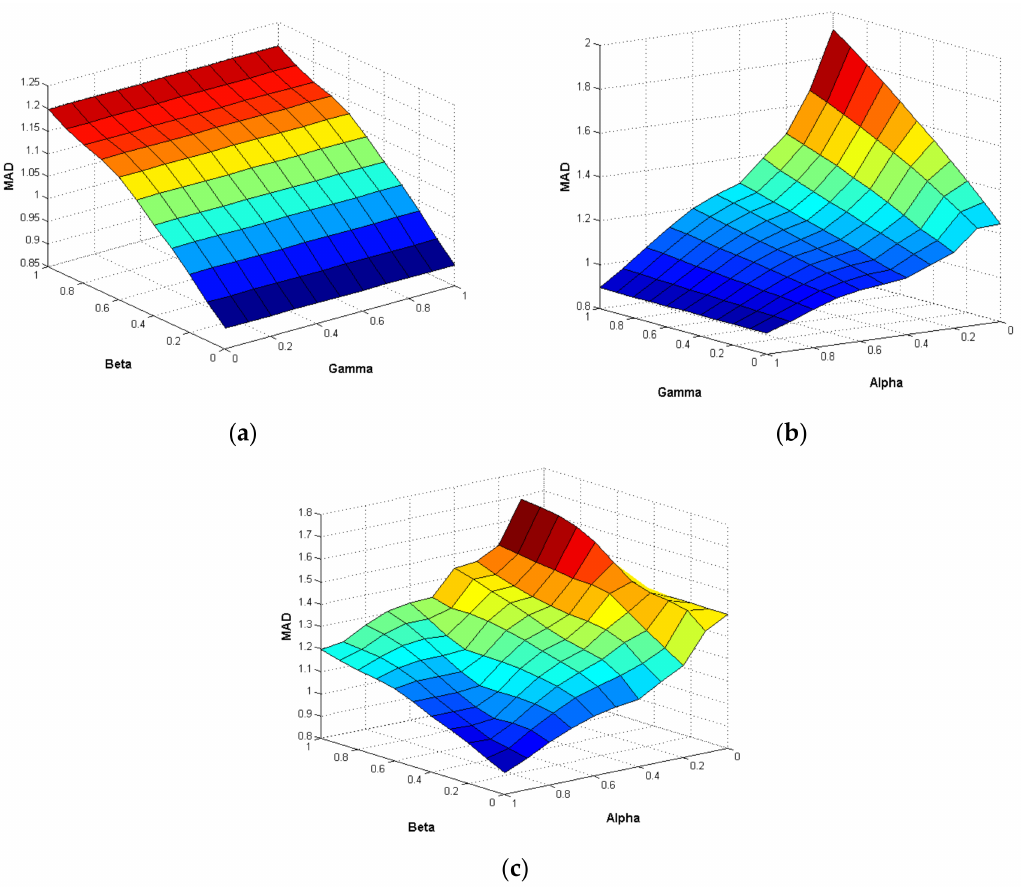
Figure 4. Convergence of mean absolute deviation ( MAD ) at ( a ) constant α = 1; ( b ) constant β = 0; ( c ) constant γ =